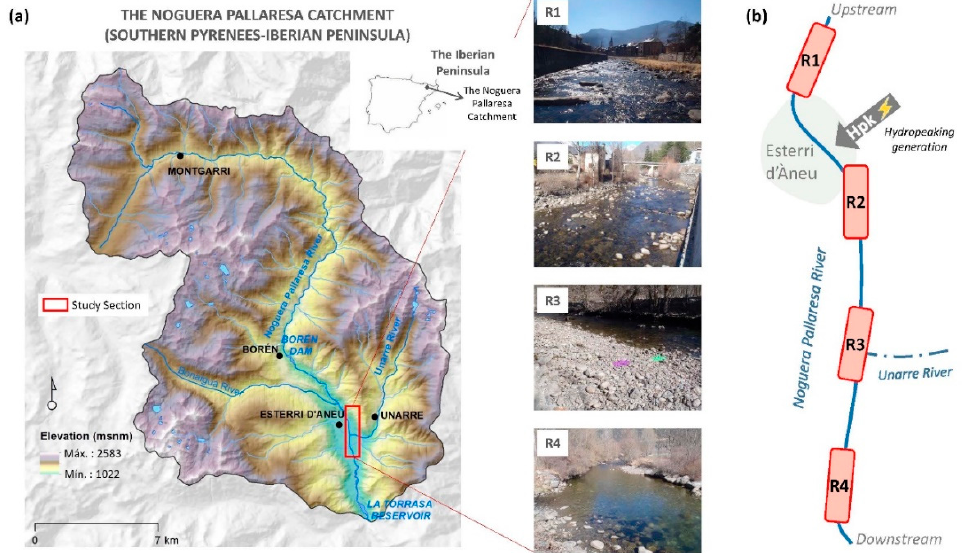
Figure 1. ( a ) Location of the Upper Noguera Pallaresa River (NE Iberian Peninsula) and the study section. ( b ) Schematic view of the study section and the specific four study reaches, together with